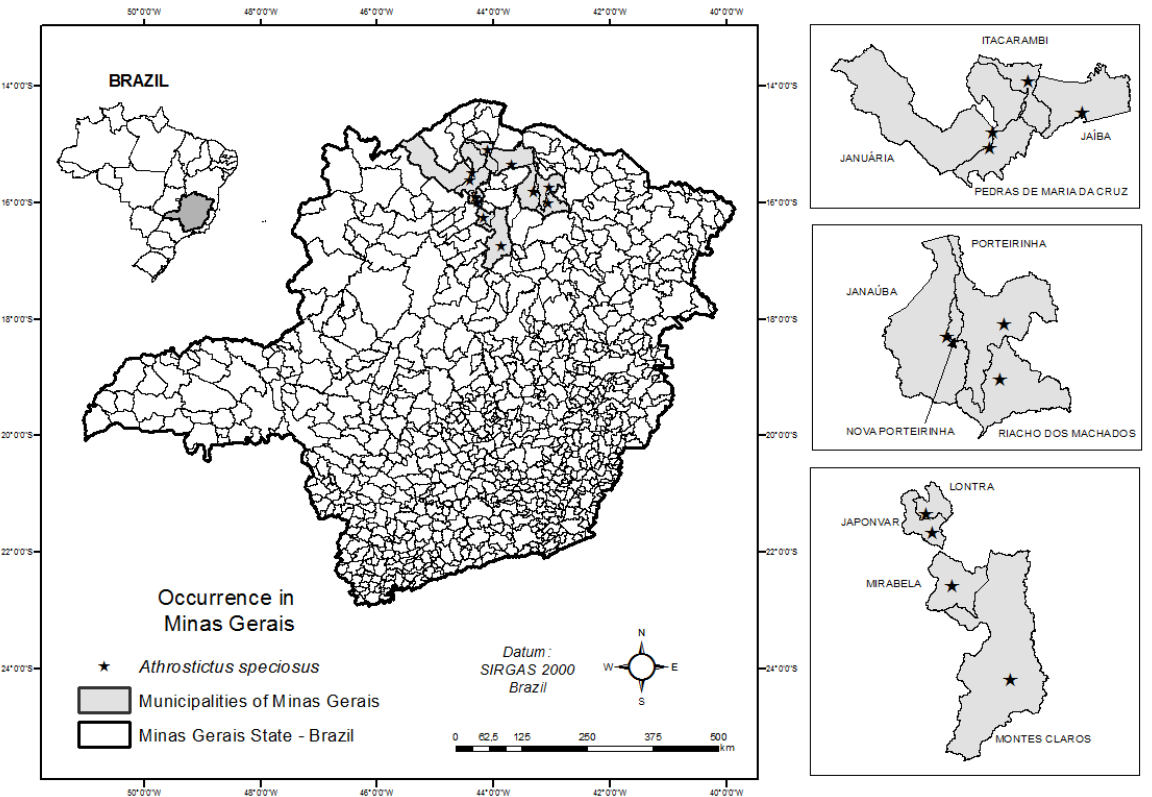
Figure 1. Municipalities of the northern region of Minas Gerais State, Brazil with recorded occurrence of Neoaulacoryssus speciosus (Coleoptera: